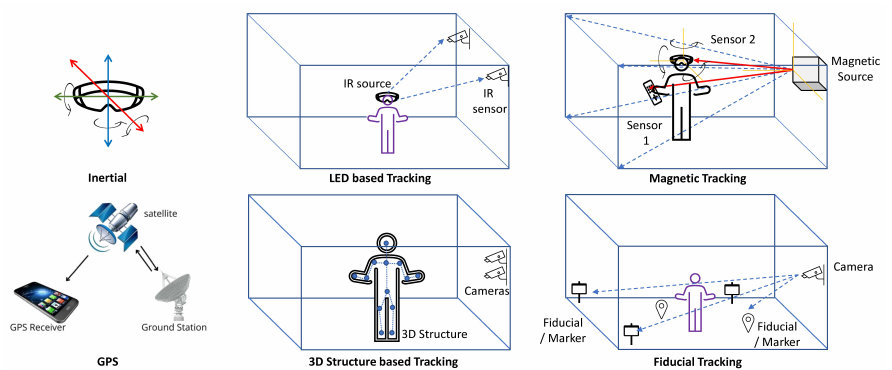
Figure 5. Augmented reality tracking techniques